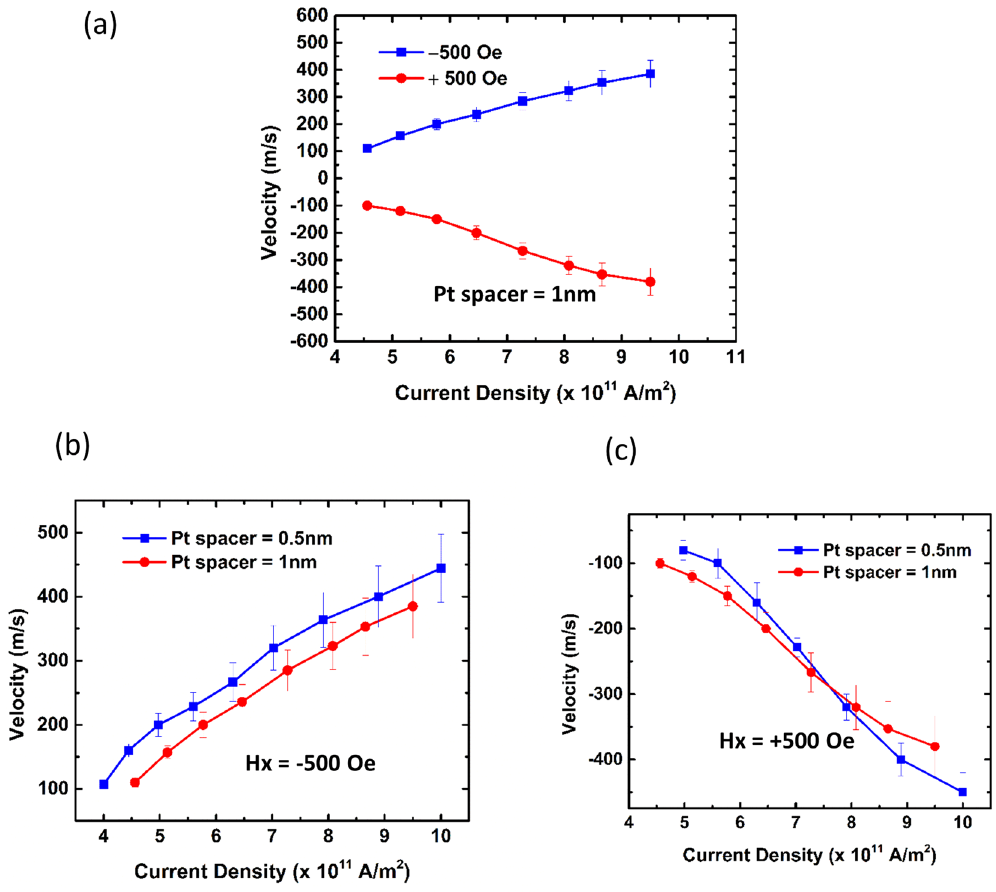
Figure 4. ( a ) DW velocity versus current density in the presence of a constant in-plane magnetic field in + x and − x -directions for 1-nm-thick Pt spacer; plot symmetry across x-axis reveals low DMI strength. DW velocity for Pt spacer with thicknesses 0.5 nm and 1 nm when a magnetic field was applied along ( b ) − x - direction, and ( c ) + x -direction. Comparison indicates increasing Pt spacer thickness reduces